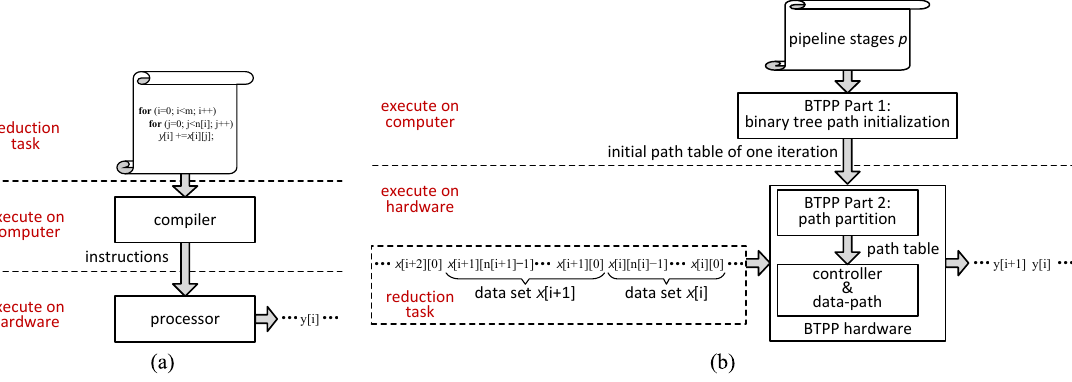
Figure 4. The workflow of the reduction task in Figure 1a on different hardware. ( a ) execute on the processor; ( b ) execute on BTPP